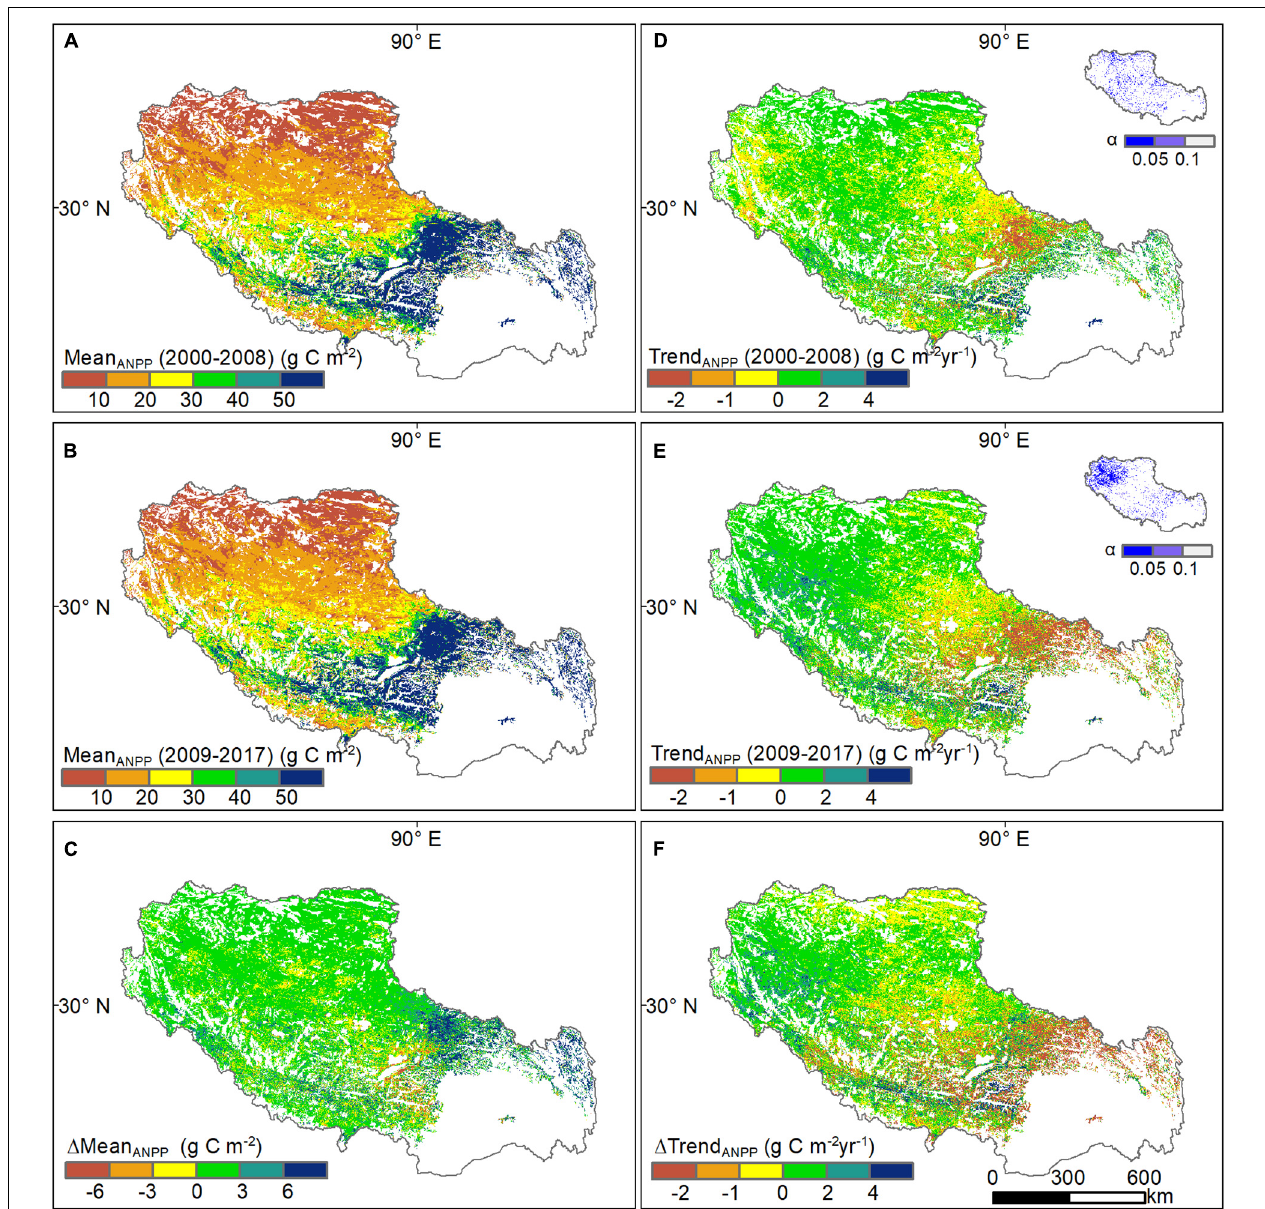
FIGURE 5 | Changes in grassland ANPP across Tibet. (A,B) The average of grassland ANPP in the two subperiods, before (2000-2008) and after (2009–2017) starting the “ Ecological Security Barrier Protection and Construction Project .” (C) The mean-difference of grassland ANPP between the two subperiods. (D,E) The changing trend in grassland ANPP in the two subperiods. (F) The trend-difference in grassland ANPP between the two